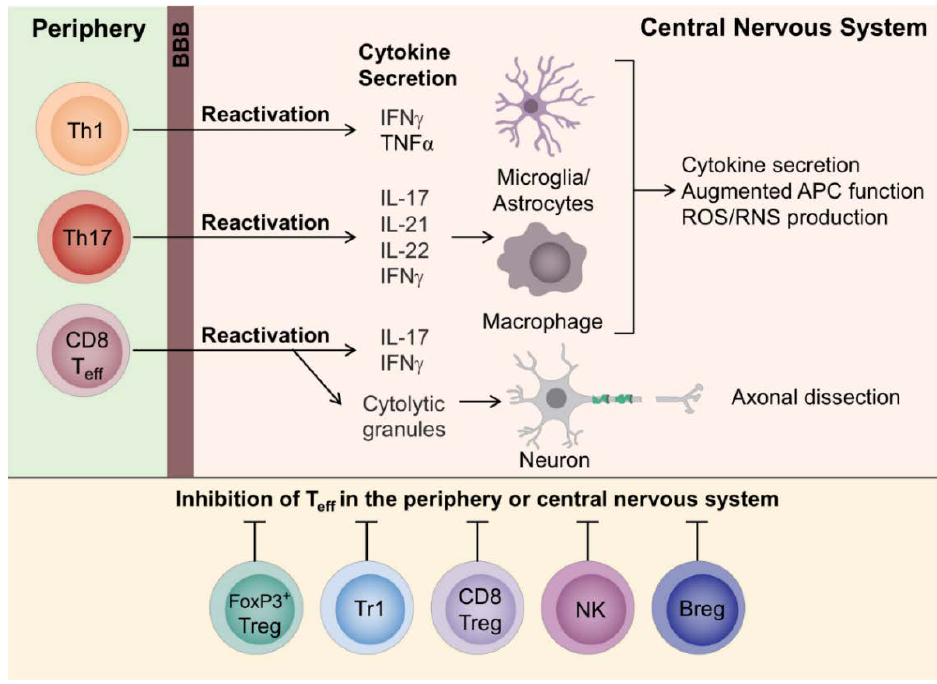
Figure 2. Effector T cells in multiple sclerosis (with the permission of [2]). Figure 2. E ff ector T cells in multiple sclerosis (with the permission of